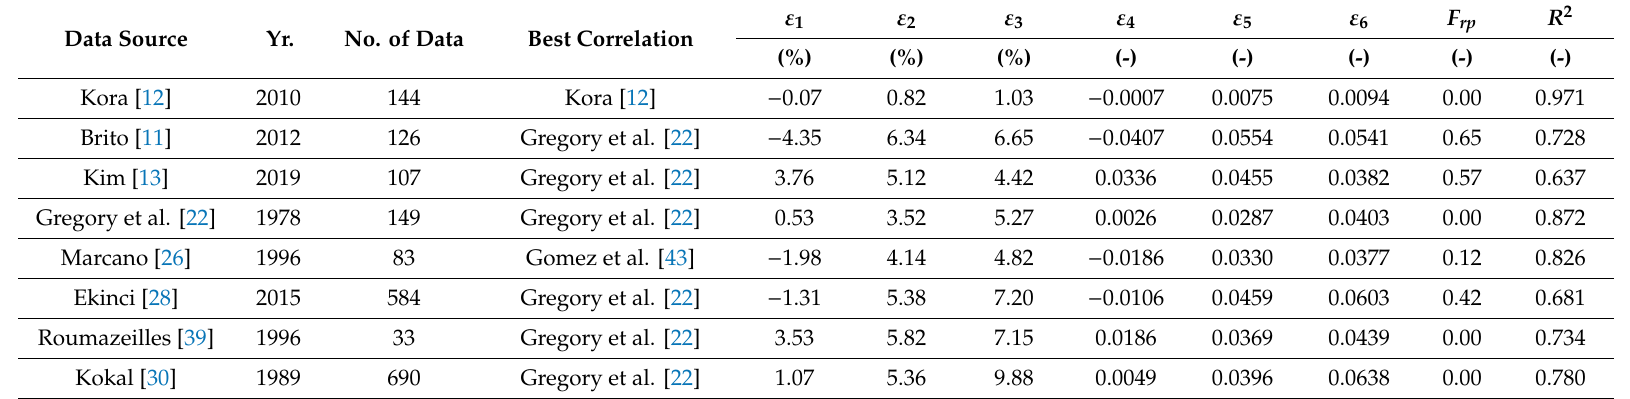
Table 6. Summary of the best performing correlations of slug liquid holdup, H LLS